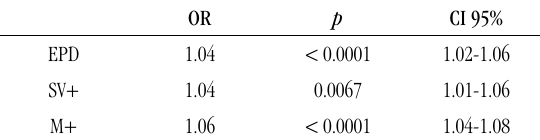
tABLE 4 – Multiple logistic regression analysis of the percentage of affected fragments in the prediction of pathological findings